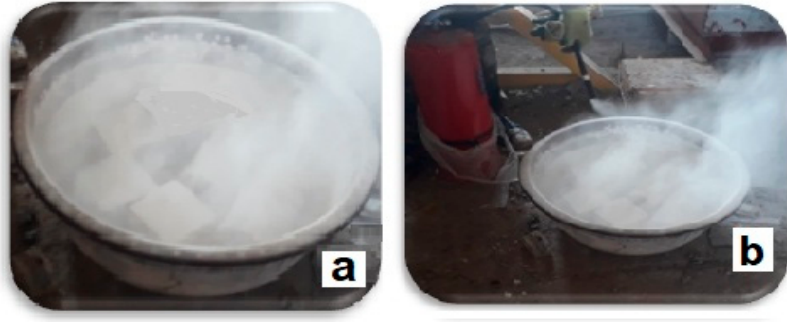
Figure 2. Cooling methods ( a ) Sudden-cooling; ( b ) Foam-cooling method. Table 1. Cement properties. L.O.I.: loss of ignition, IR: insoluble residue and L.S.F.: lime saturation factor.